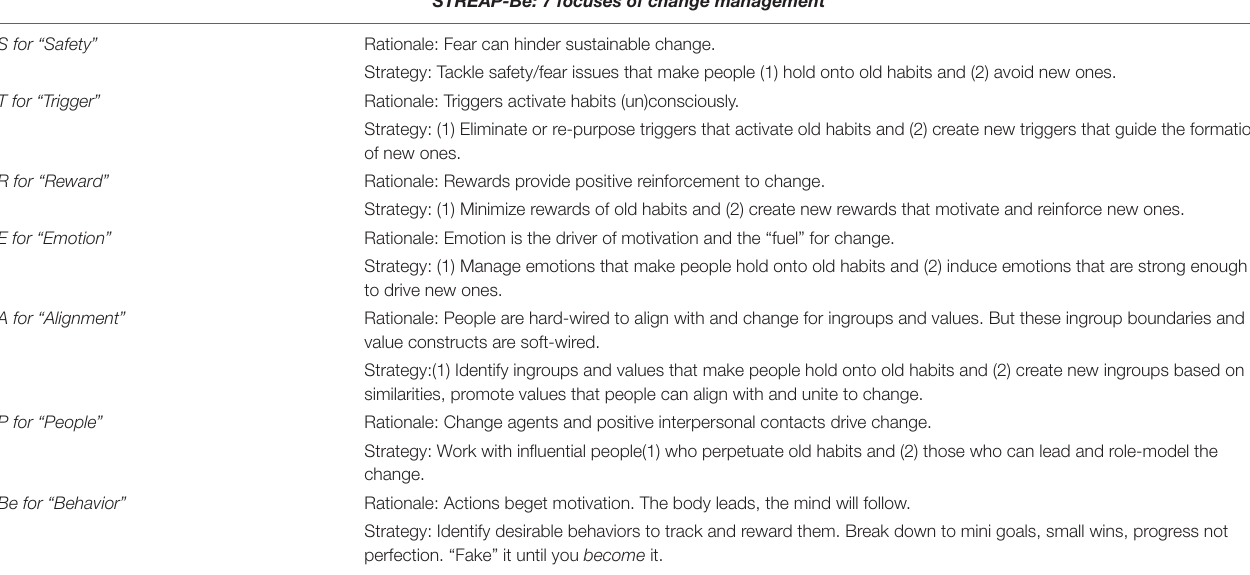
TABLE 1 | STREAP-Be model of 7 focuses in change management (Nguyen-Phuong-Mai, 2019). STREAP-Be: 7 focuses of change management Rationale: Fear can hinder sustainable